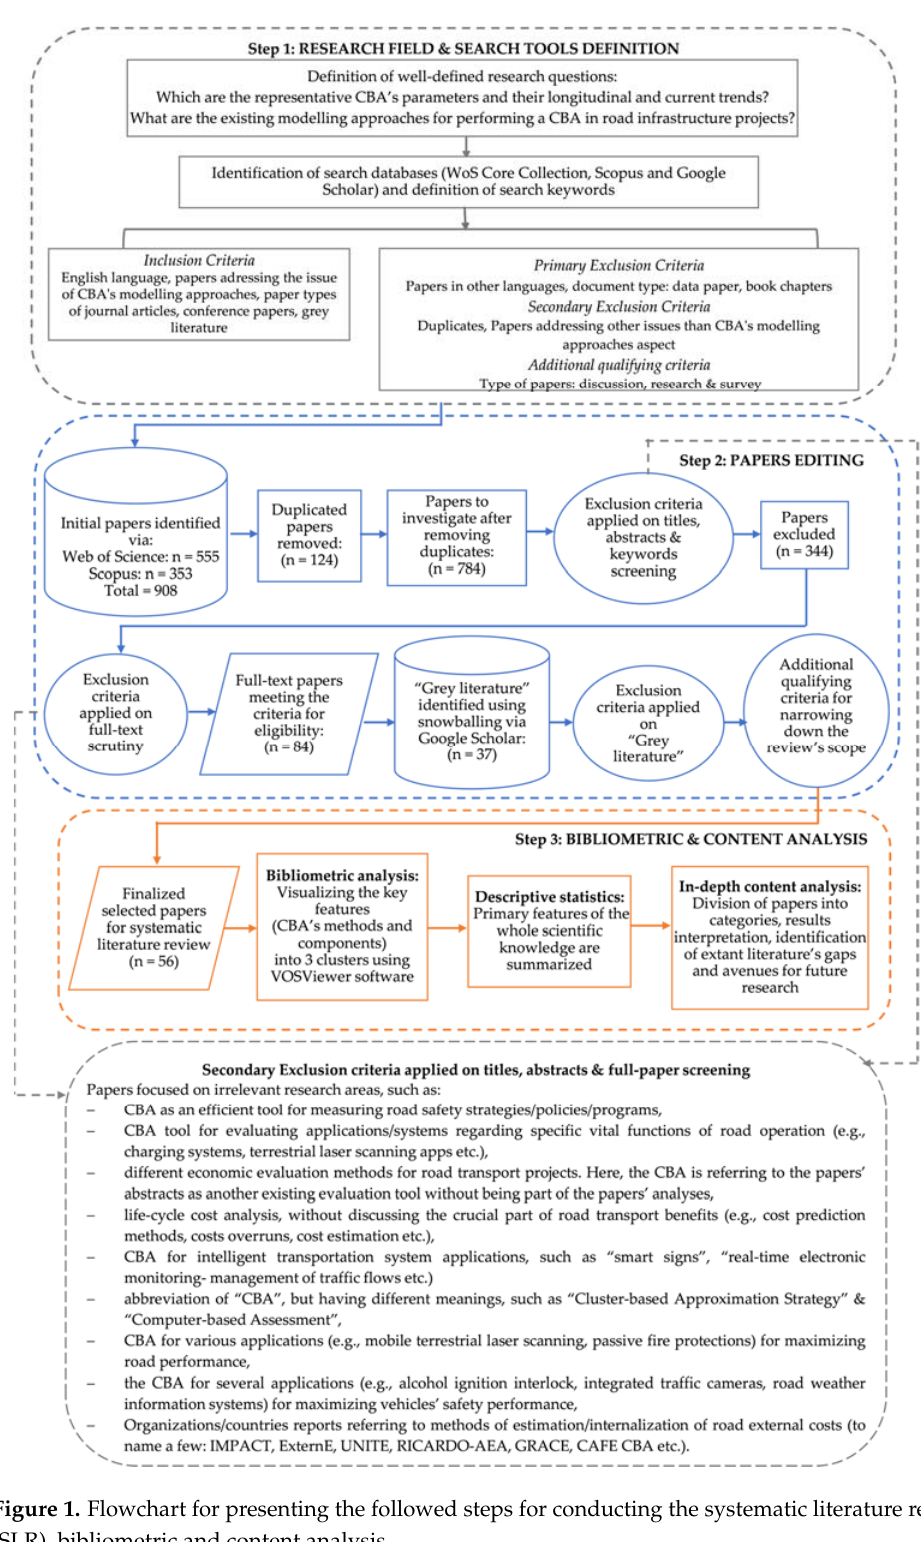
Figure 1. Flowchart for presenting the followed steps for conducting the systematic literature review (SLR), bibliometric and content analysis.